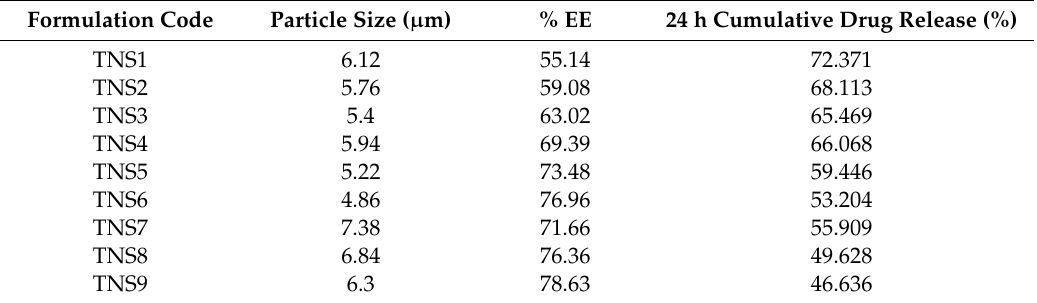
Table 9. Evaluations for KTZ